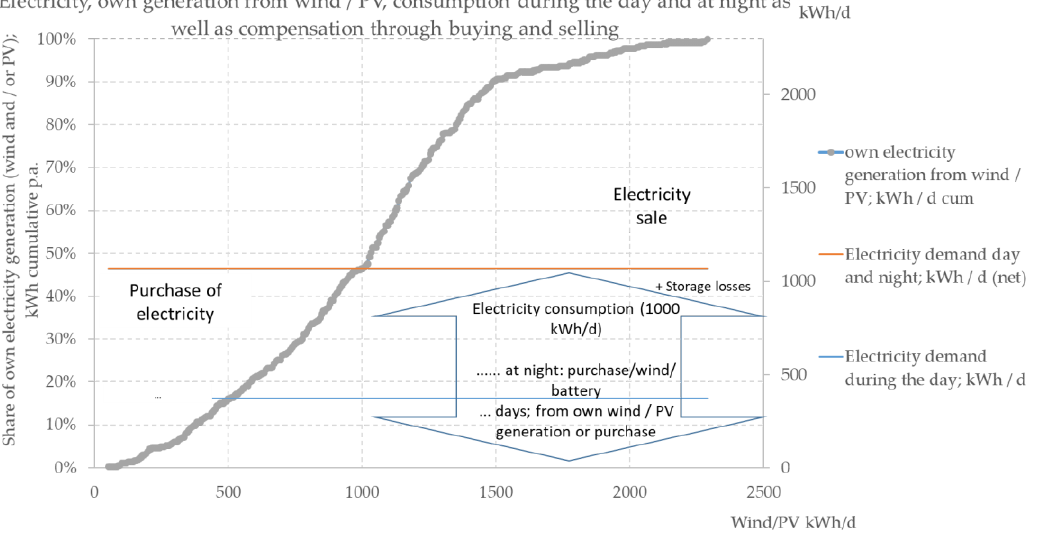
Figure 7. Annual electricity production potential from the farm’s own generation (50% wind and 50% PV), consumption during the day and at night, balancing by a battery, buying and selling. Requirement values, 50% during the day and 50% at night; battery power 500 kWh/d; battery utilization over the year 13%; self-sufficiency 76%.